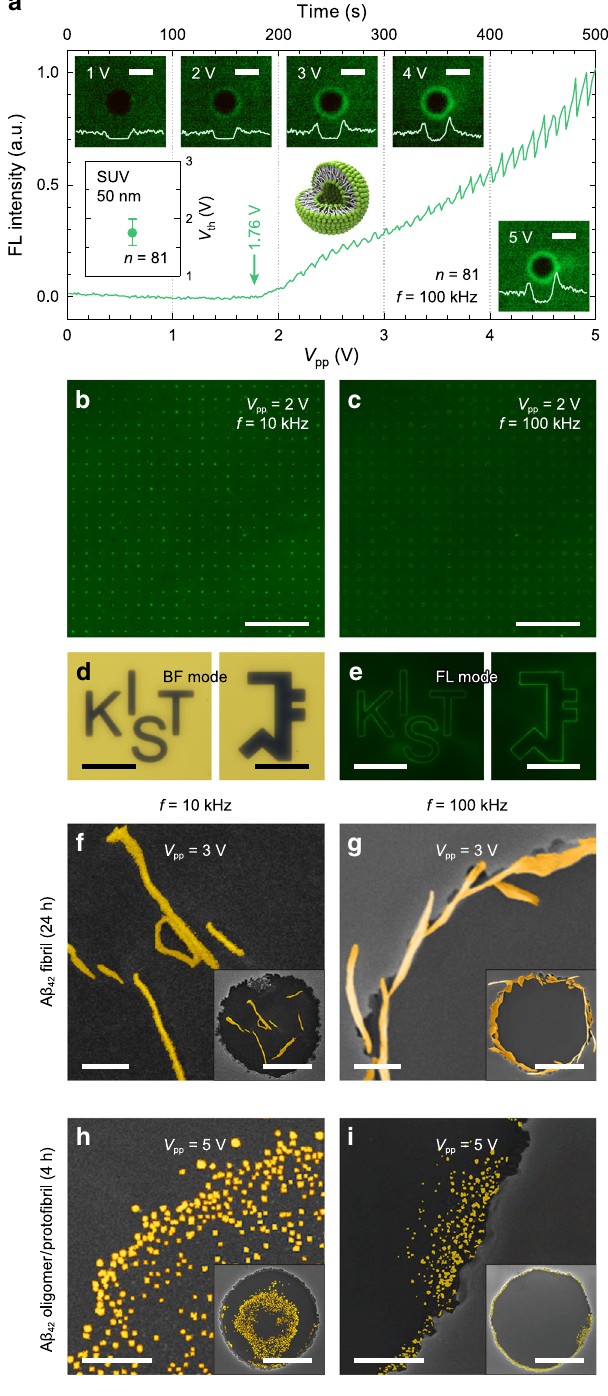
incubated separately with different durations (4 h vs 24 h) in deionized water at 37 °C and stained with thio fl avin-T for visualization, and the A β 42 solution was diluted into 1 nM to emulate the actual ultra-low concentration of A β 42 peptide. Prior